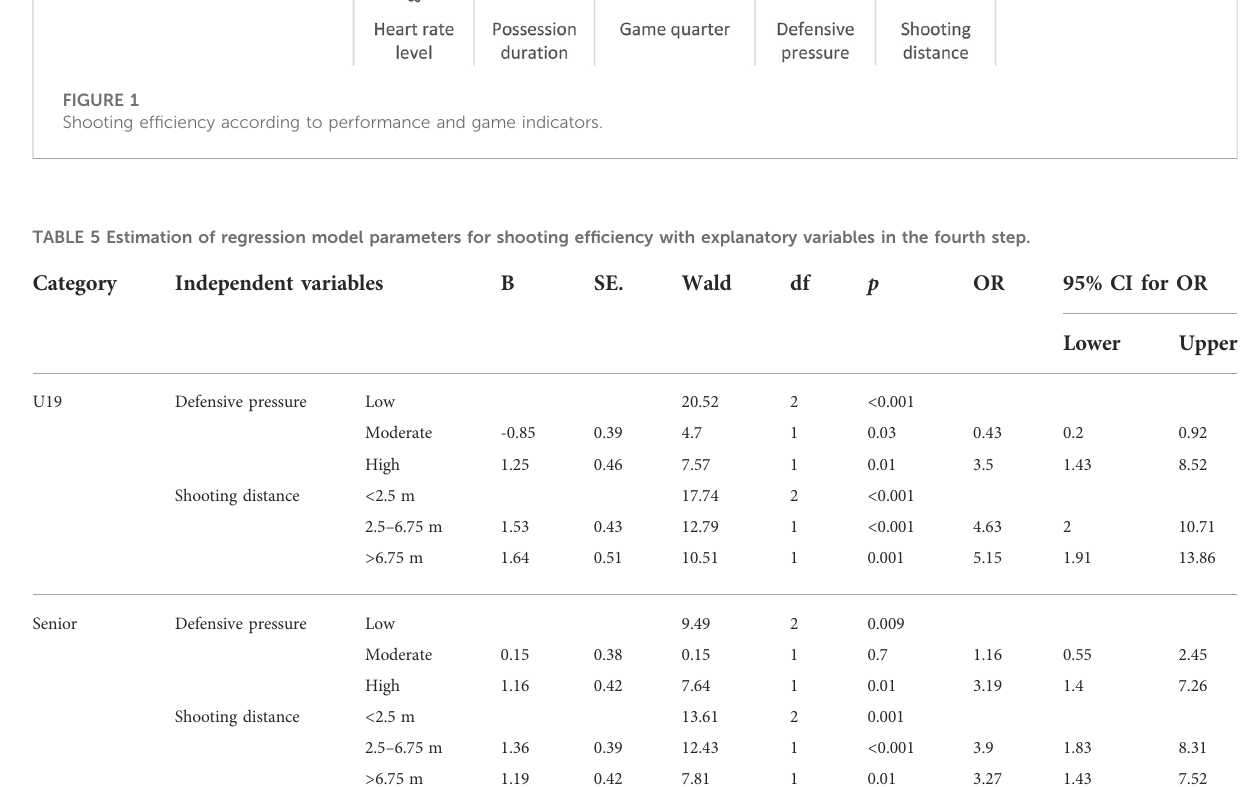
FIGURE 1 Shooting ef fi ciency according to performance and game indicators.